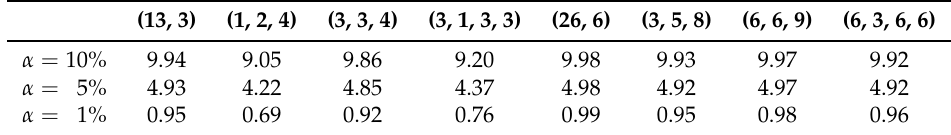
Table 2. P ( Ba/ C > c α ) where c α is the χ 2 α critical value. Results are in %. Degrees of freedom shown as ( df 1 , . . . , df m )